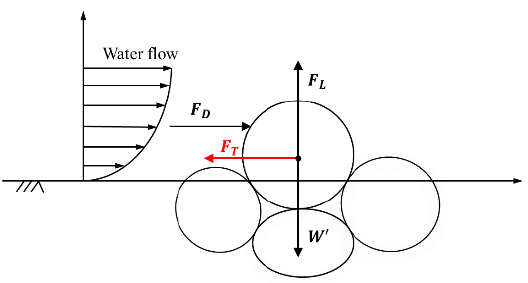
Figure 10. Force analysis of reinforced tailings particles.